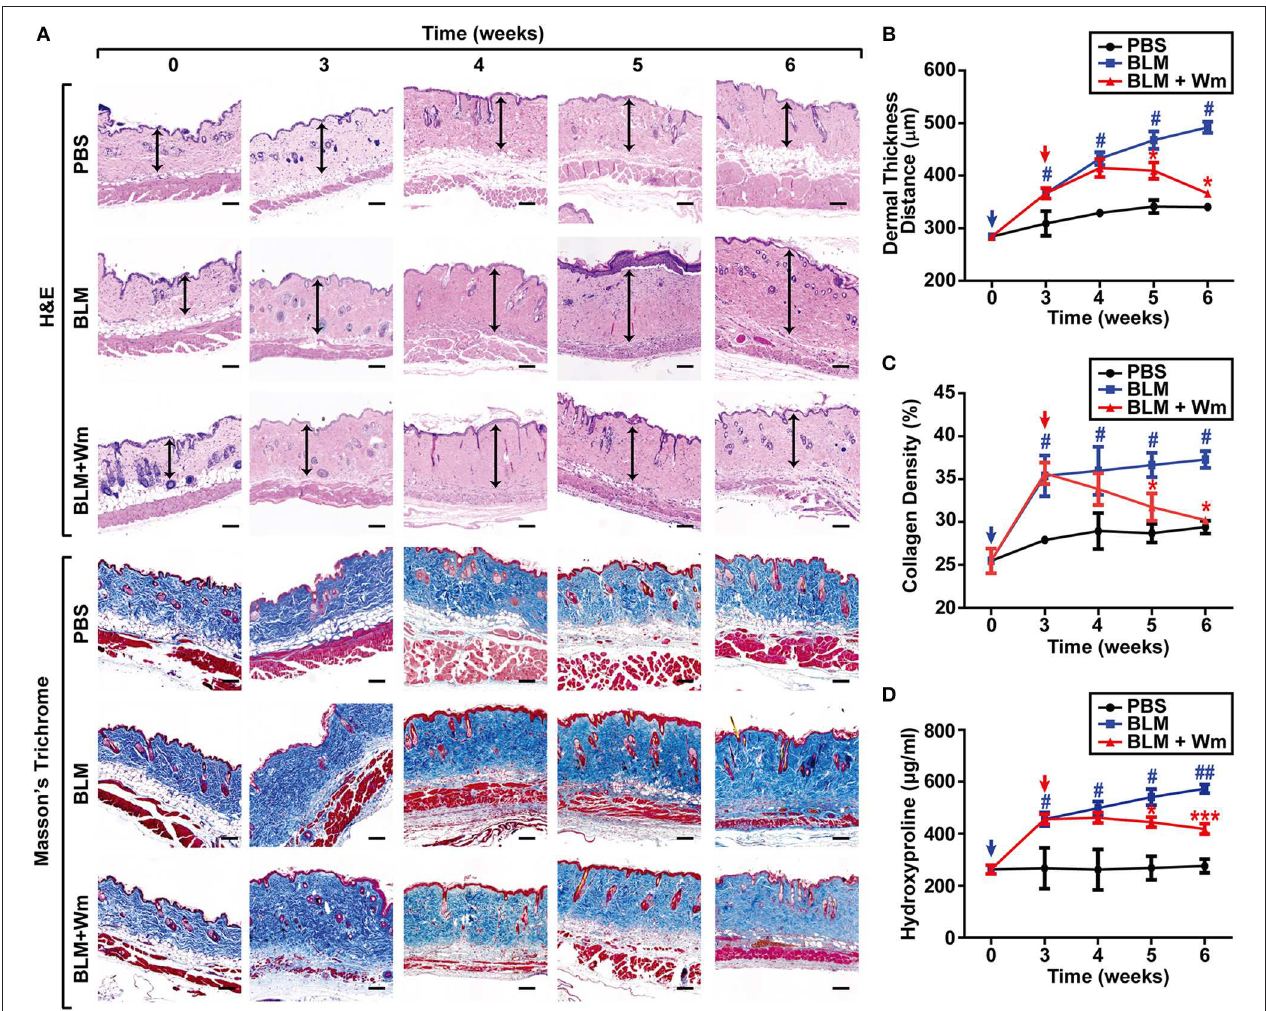
FIGURE 2 | Time-dependent effects of WKYMVm treatment on tissue fibrosis in scleroderma mice model. (A) Time dependence of WKYMVm-induced repair of scleroderma. The BLM-induced scleroderma mice were treated without (BLM) or with 1 µ M Wm (BLM + Wm) for the indicated time periods. The mock-treated (PBS) and the scleroderma (BLM or BLM + Wm) skin specimens were stained using H&E and Masson’s Trichrome staining kits. Dermal layer between the epidermal-dermal junction and the dermal-fat junction was indicated with an arrow on H&E-stained sections. Dermal thickness (B) and collagen density (C) were quantified from the H&E and Masson’s Trichrome staining data, respectively. (D) The effects of Wm on the levels of hydroxyproline content in skin specimens were determined. Data are shown as the mean ± SD ( n = 8). # p < 0.05, ## p < 0.01 vs. PBS; * p < 0.05, *** p < 0.001 vs.